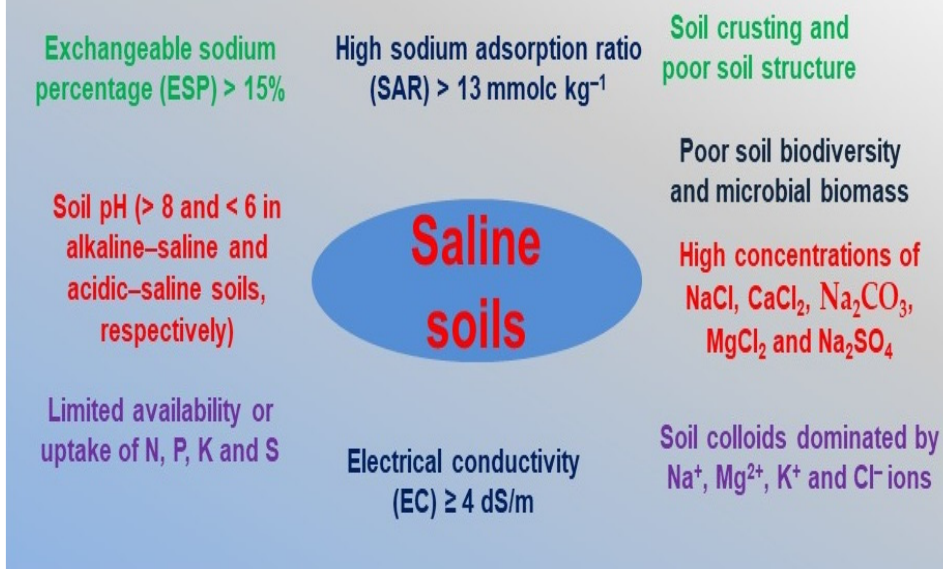
Figure 1. A general summary of the characteristics of salt-affected